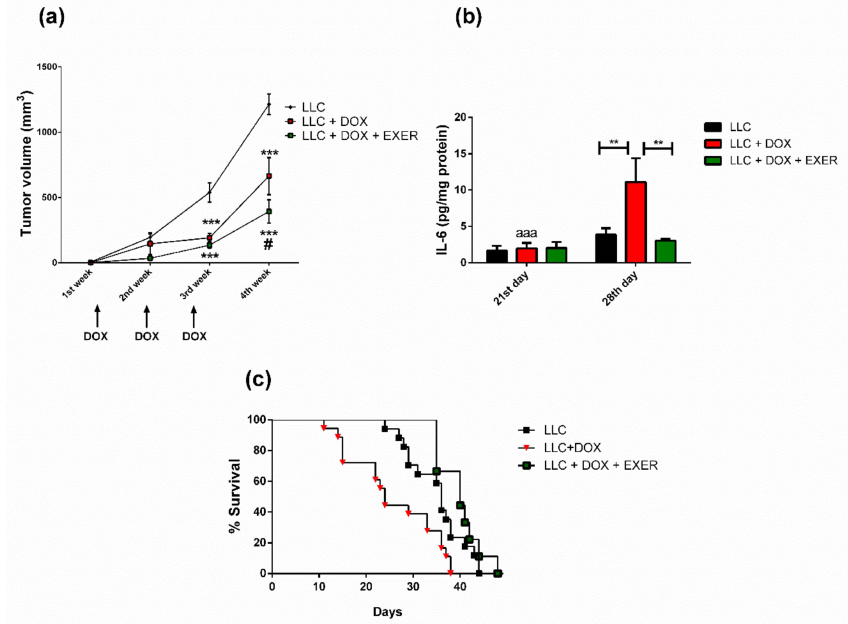
Figure 2. E ff ect of chemotherapy treatment and of the combination of endurance exercise on tumor growth. ( a ) Tumor growth curve (mm 3 ). n = 20–18. *** p < 0.001 vs. LLC group. # p < 0.05 vs. LLC + DOX group. ( b ) IL-6 concentration (pg / mg protein) in tumor homogenate. n = 5–6. ** p < 0.01; aaa: p < 0.001 compared with the respective group on the 28th day. ( c ) E ff ect of doxorubicin and endurance exercise on the survival of mice. The survival was assessed using the Kaplan–Meier curve and was compared using a log-rank test for trend. n = 18–9. Values represent the mean and standard error of the mean of the analysis of the data obtained. LLC = Lewis lung carcinoma; DOX = doxorubicin; EXER = endurance